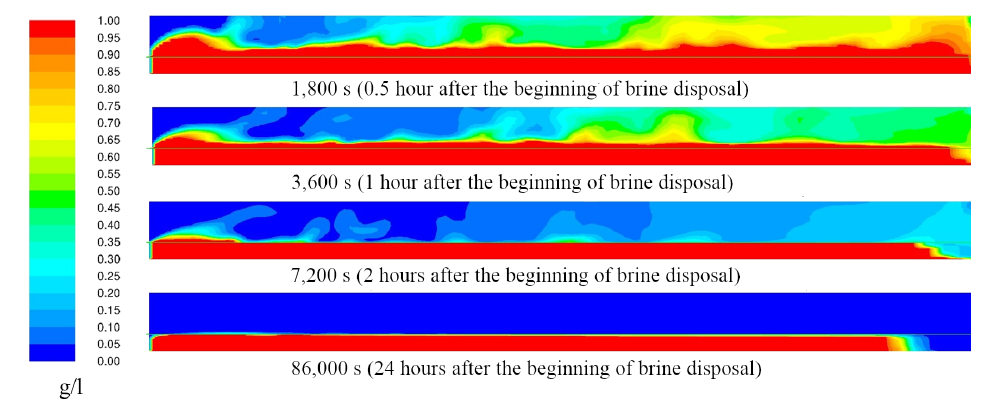
Figure 12. The impurity concentration in a vertical section at the middle of the computational domain after the cessation of brine